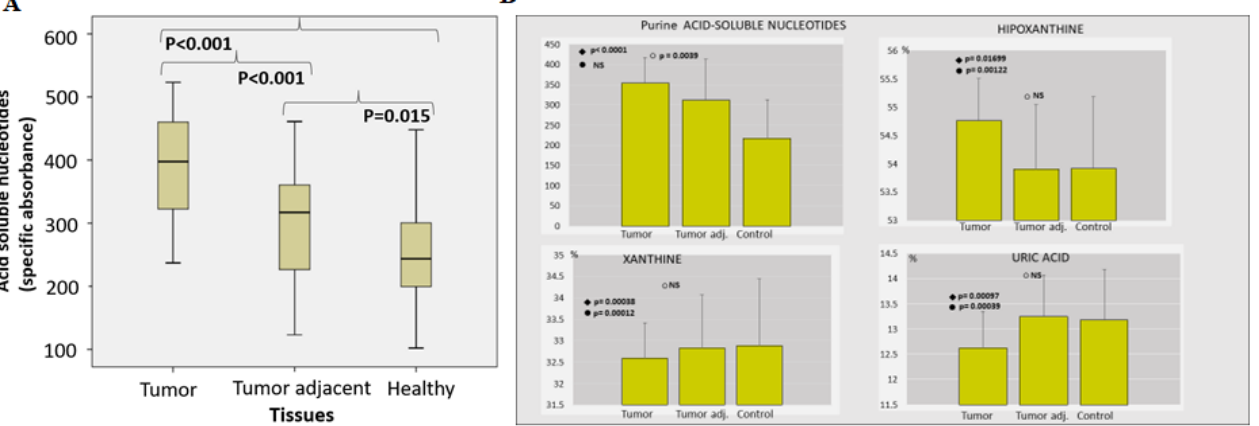
Figure 2. The pool of acid-soluble nucleotides in PC. (Acid soluble nucleotides (specific absorbance) ( A ) and percentual share (%) of hypoxanthine, xanthine and uric acid among purine acid soluble nucleotides ( B ) in prostate cancer, tumor adjacent and healthy tissue, accordingly).